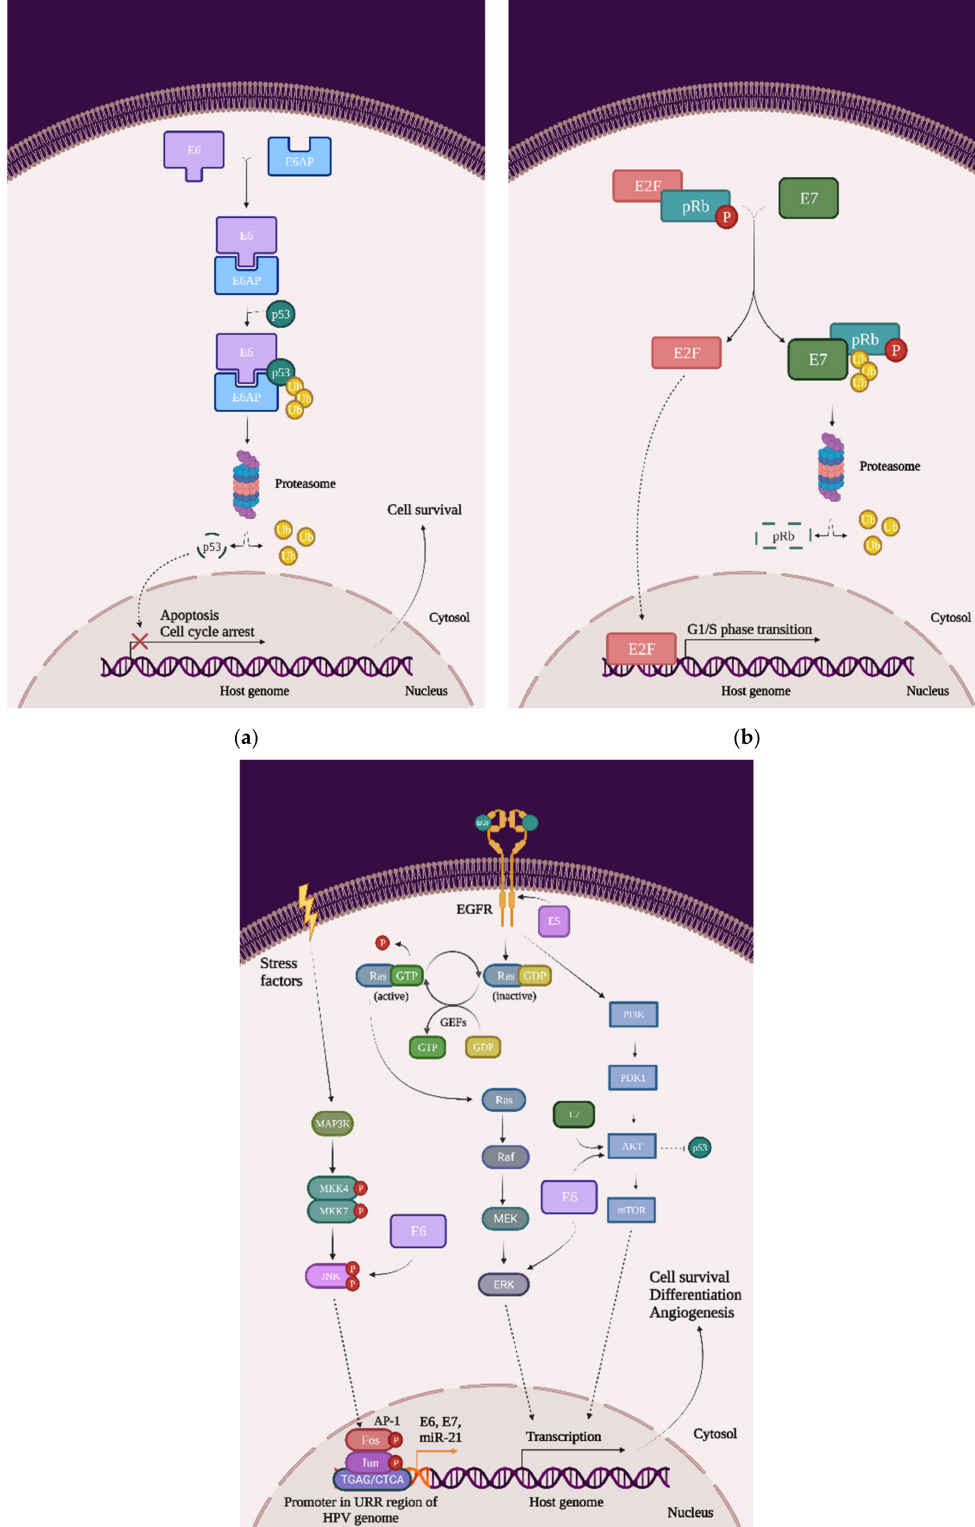
Figure 4. The impact of HPV viral proteins on the main signaling pathways responsible for cell survival, proliferation, and differentiation: ( a ) the effect of the E6 oncoprotein on the p53 tran-scription factor; ( b ) the effect of the E7 oncoprotein on the pRb tumor-suppression protein; and ( c ) the effects of the E5, E6, and E7 oncoproteins on EGFR phosphorylation, the PI3K/Akt/mTOR pathway, JNK, ERK, and the AP-1